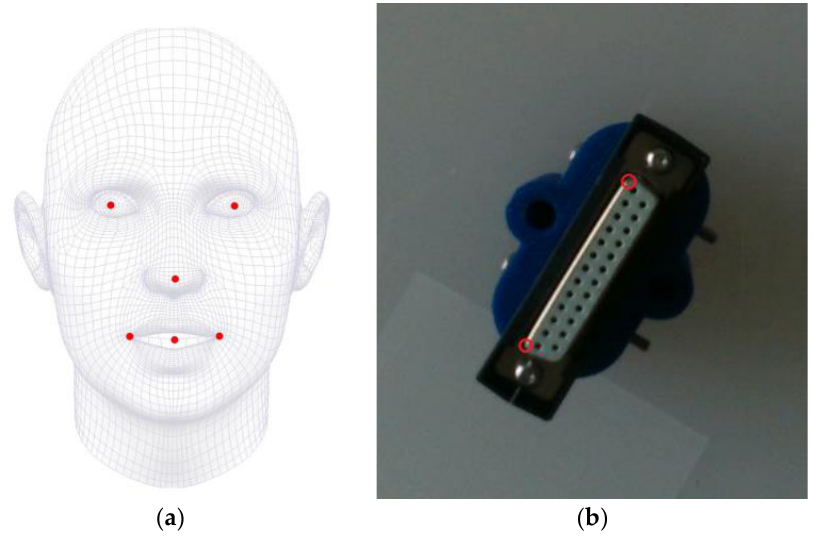
Figure 3. Landmark definition. ( a ) Face landmarks in AFW. ( b ) Workpiece